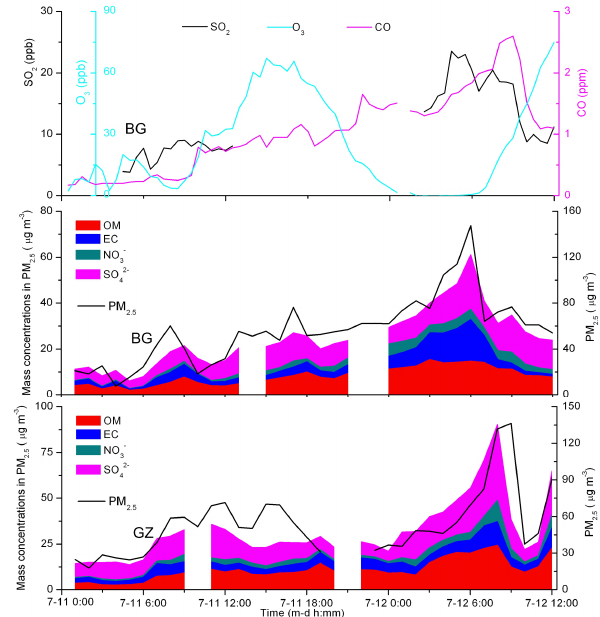
Fig. 3. Variations of trace gases at BG, PM 2 . 5 , and mass con- centrations of chemical compositions in PM 2 . 5 at both sites from 00:00LT, 11 July to 12:00 LT, 12 July.